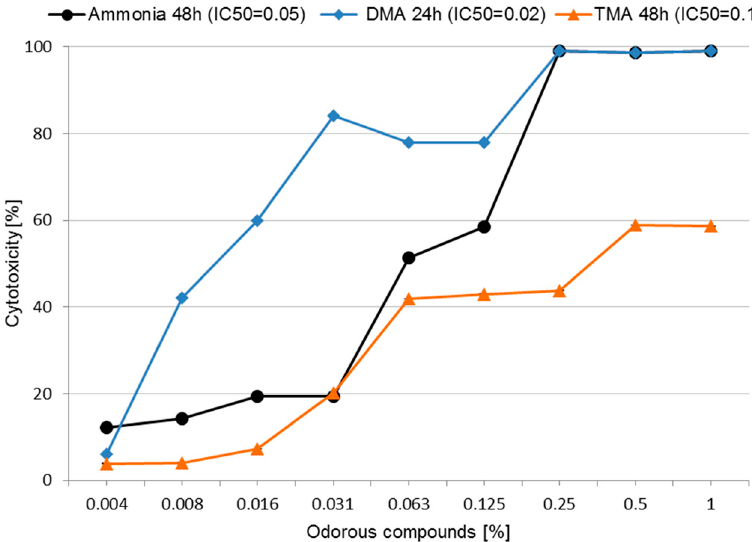
Figure 2. Cytotoxicity of ammonia, dimethylamine (DMA) and trimethylamine (TMA) in Lactate Dehydrogenase Activity (LDH) assay in LMH chicken cell line after 24 h (DMA) and 48 h (ammonia and TMA) exposure. Each data point represents the mean of the absorbance values of cells from eight individual wells ( ± SD). * p < 0.05 for concentrations of ammonia, DMA and TMA as compared to unexposed controls.